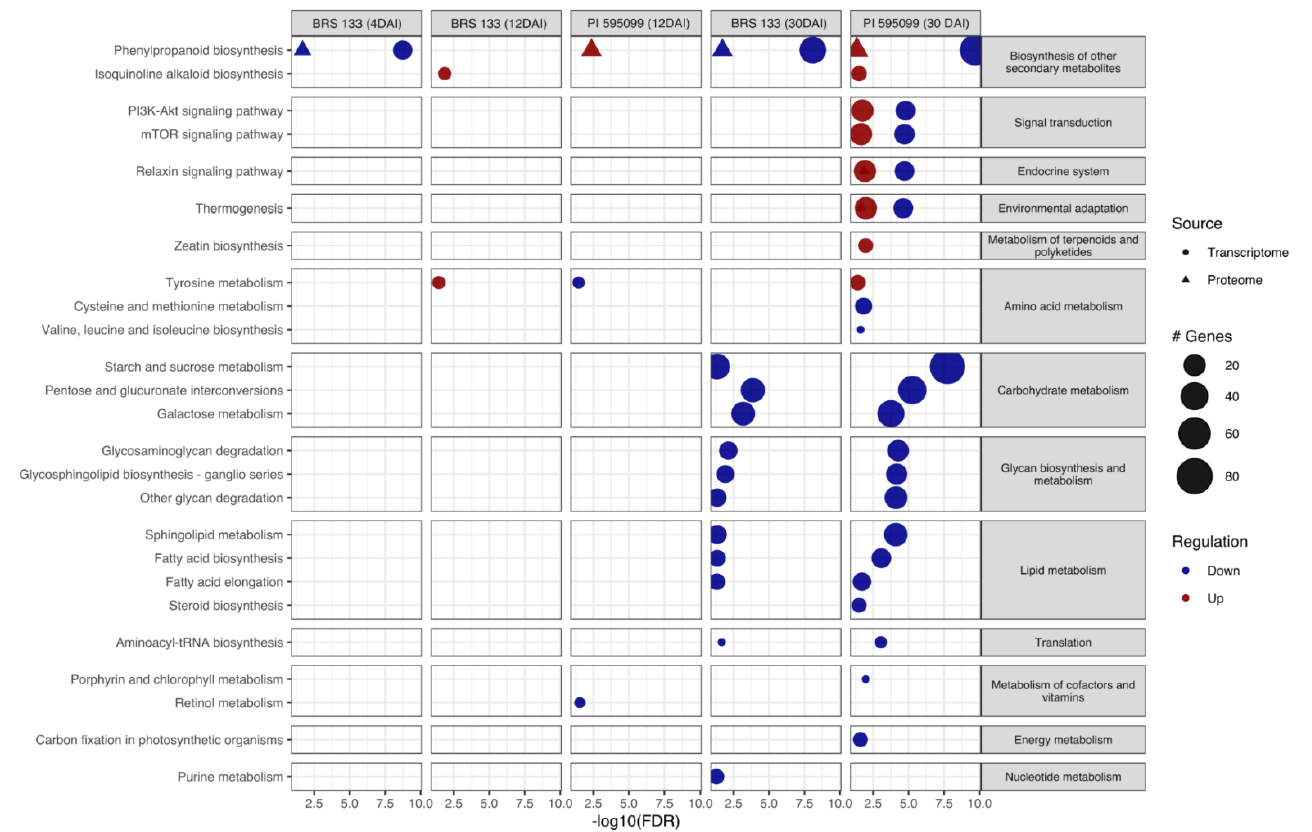
Figure 3. Enrichment of metabolic pathways from Kyoto Encyclopedia of Genes and Genomes (KEGG) database in the transcriptome and proteome of G. max infected with M. incognita . The susceptible BRS 133 and the tolerant PI 595099 genotypes are represented at the top of the bubble chart, followed by the number of days after the infection (DAI) with M. incognita . Major metabolic pathways are listed on the right (y-axis). Minor metabolic pathways are listed on the left (y-axis). Only pathways with statistical significance (false discovery rate, FDR > 0.05) are included. No enriched terms were Identified to tolerant PI 595099 genotype at 4 DAI.